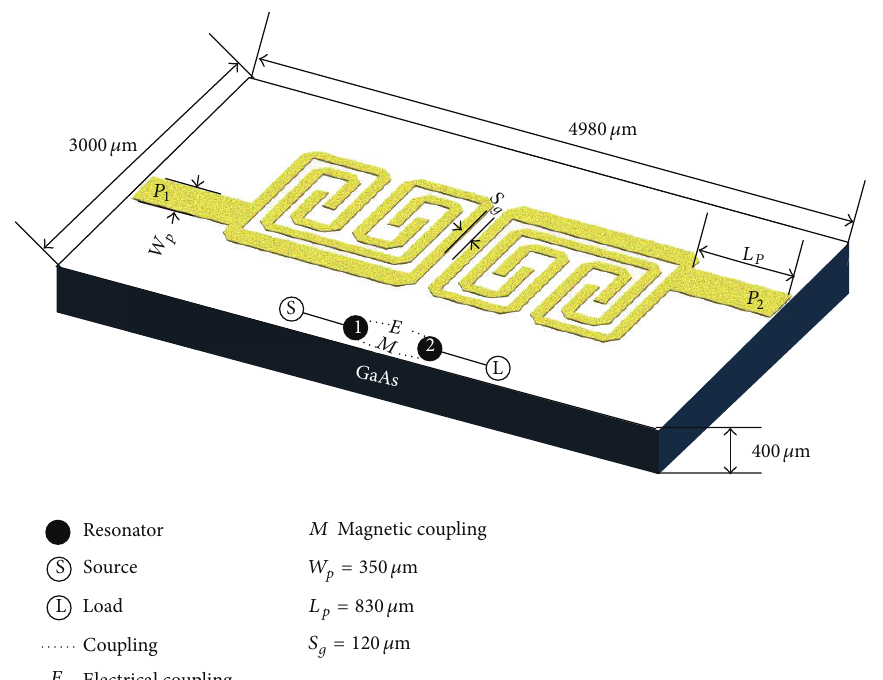
Figure 2: The layout of the proposed BPF including the coupling scheme between the resonators.